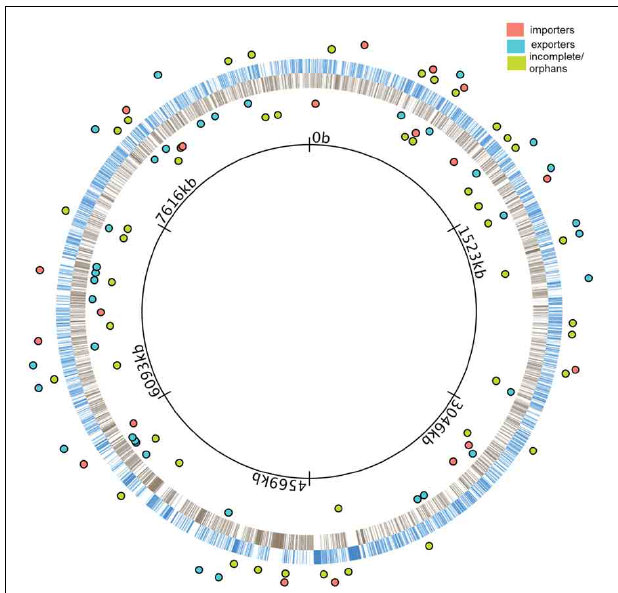
FIGURE 1 | Distribution of ABC transporters in the M. xanthus genome. The innermost black ring represents the M. xanthus chromosome. Blue bars in the outer ring represent the genes transcribed in the clockwise direction ( + strand) while gray bars in the inner ring represents the genes transcribed in the counterclockwise direction ( − strand). Colored dots represent operons containing coding genes for ABC transporters. The location of dots indicates that they are either in the + strand (outside blue ring) or in the − strand (inside black ring). Cyan and salmon colored dots represent full operons coding for complete exporters and importers, respectively. Green colored dots represent incomplete and orphan